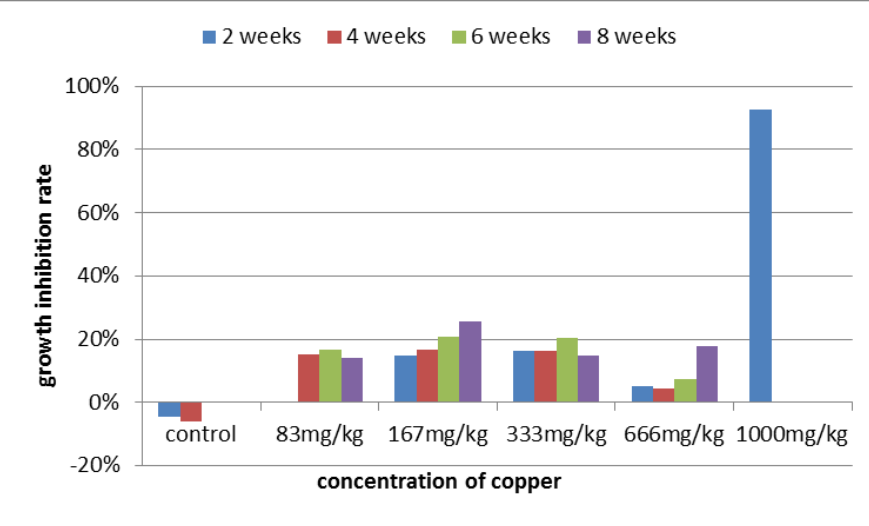
Figure 4. Growth inhibition rates of the juvenile earthworm Eisenia fetida after exposure to copper under testing